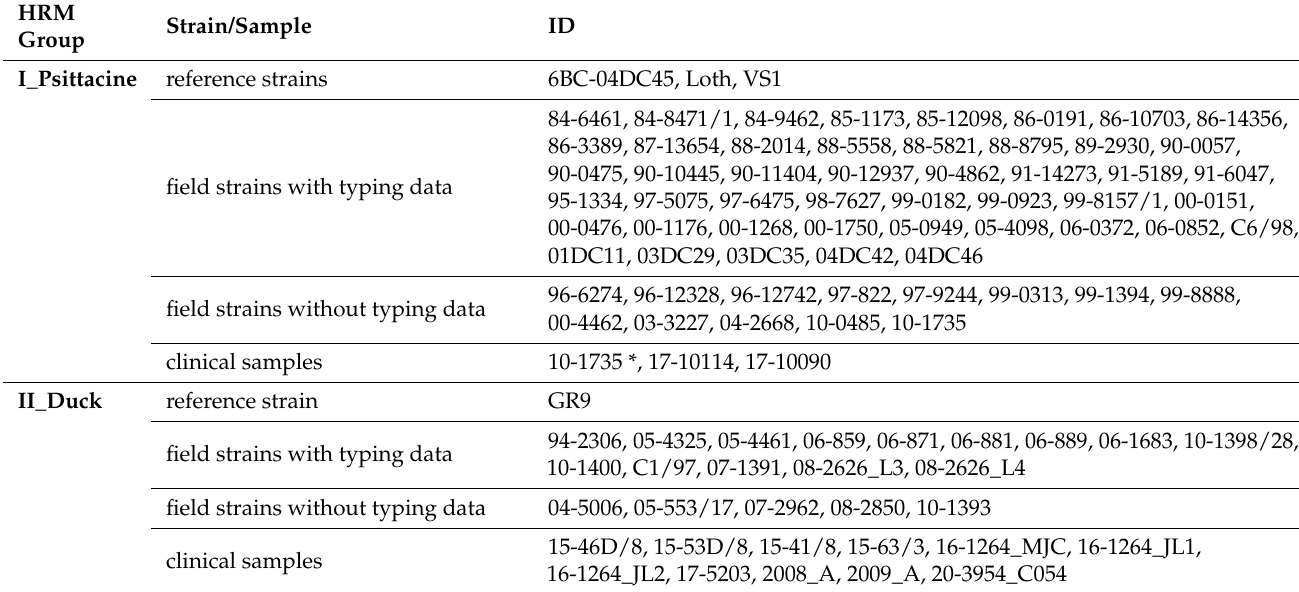
Table 1. PCR-high-resolution melting (HRM) clustering of reference strains, field strains and clinical samples. The host origin and available genotype and/or MLST results are shown in Supplementary Data